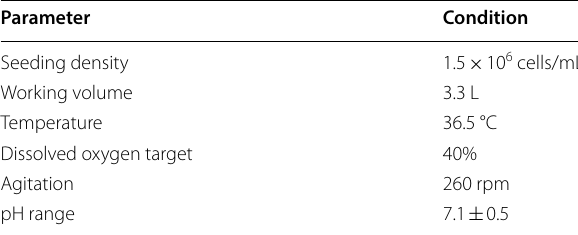
Table 2 Standard bioreactor